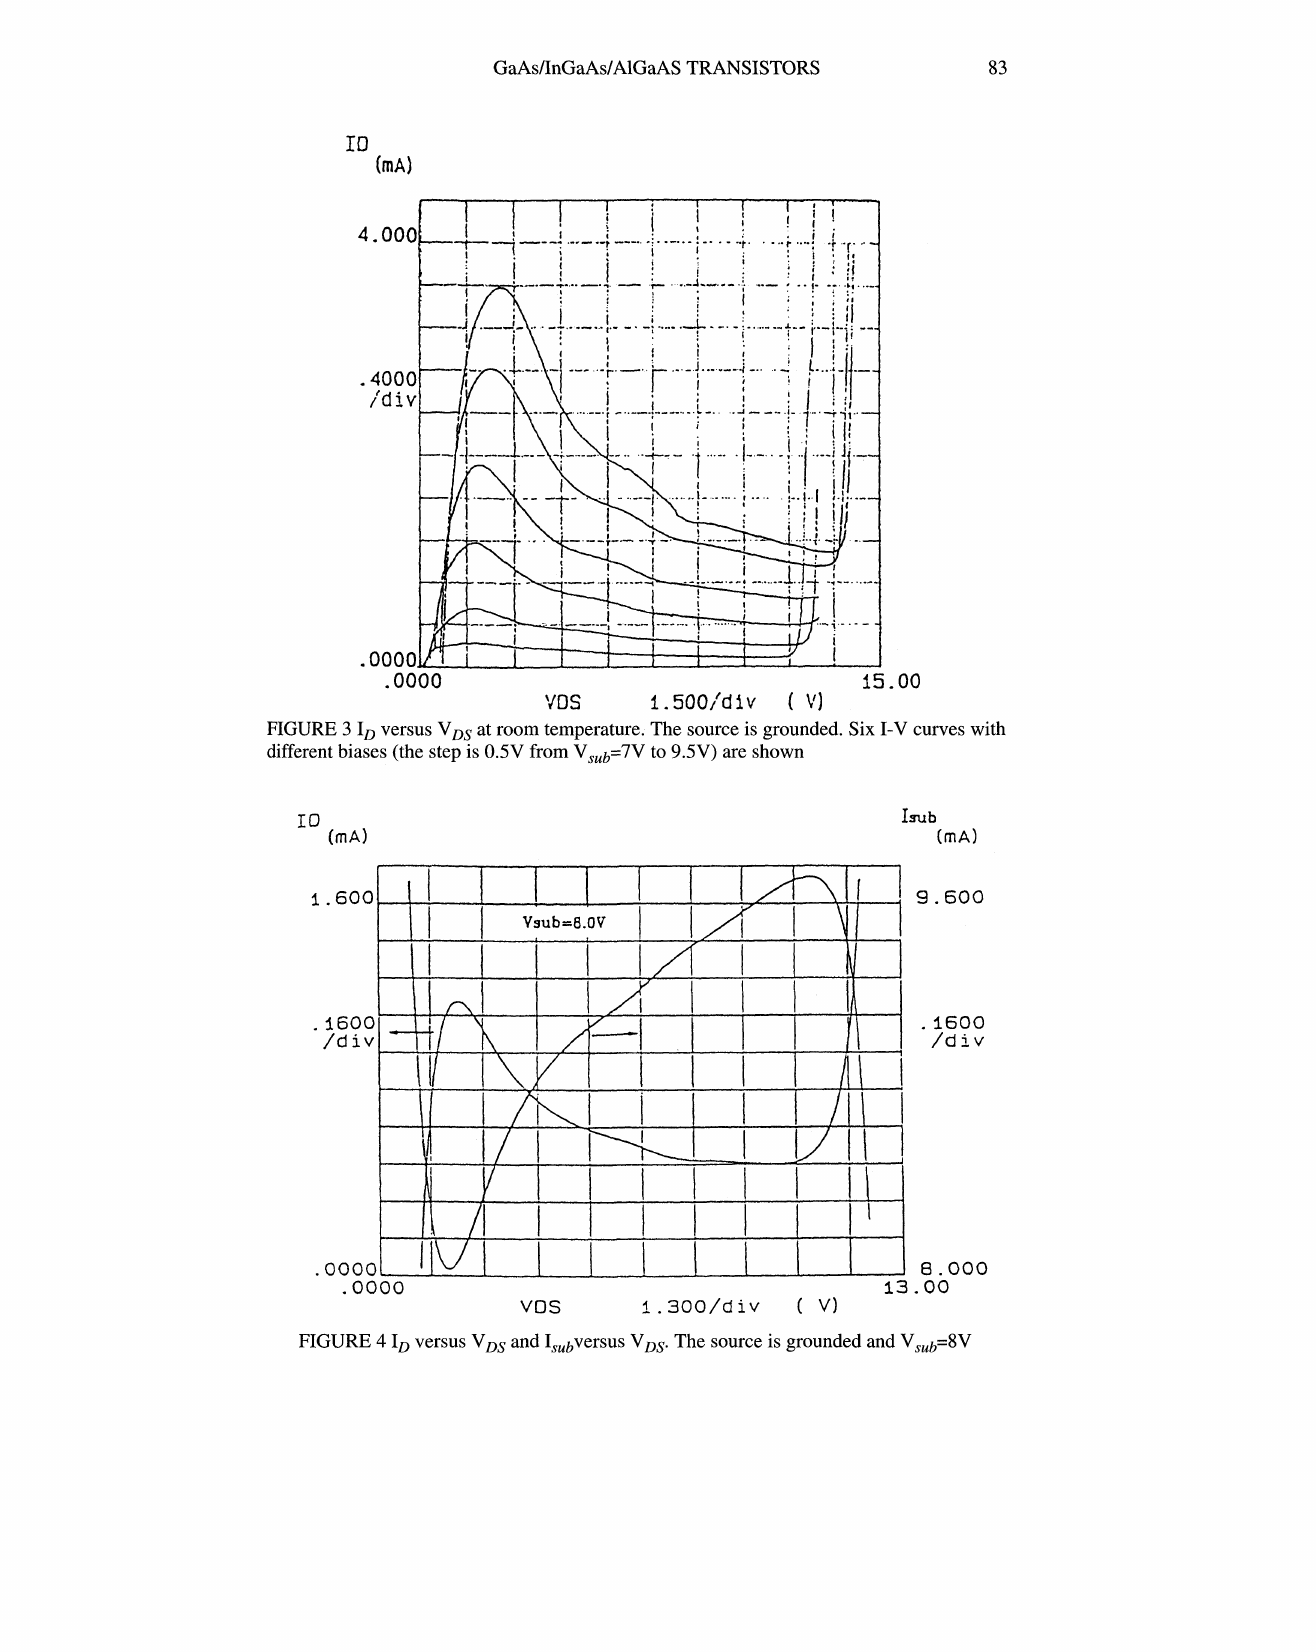
FIGURE 3 1D versus VDS at room temperature. The source is grounded. Six I-V curves with different biases (the step is 0.5V from Vsut,=7V to 9.5V) are shown